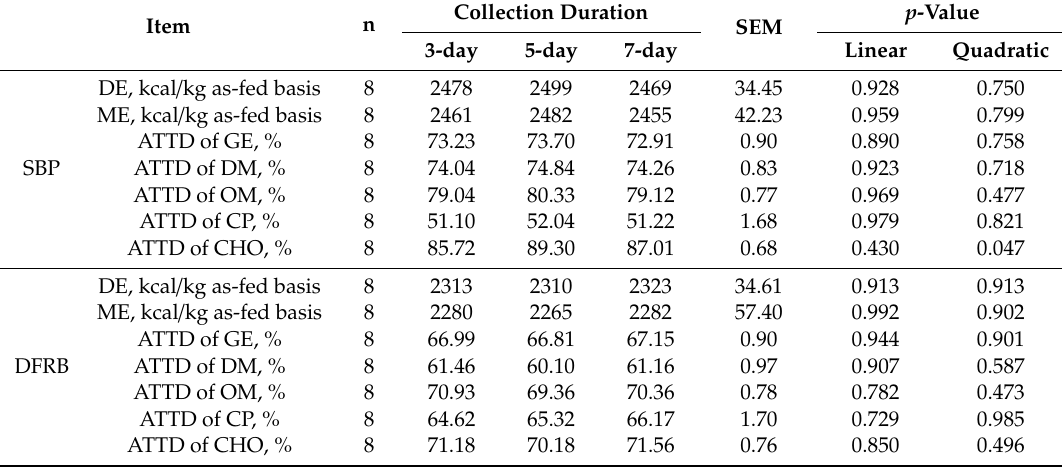
Table 5. E ff ect of collection duration on energy content, gross energy (GE), and nutrient digestibility of high-fiber ingredients fed to growing pigs 1